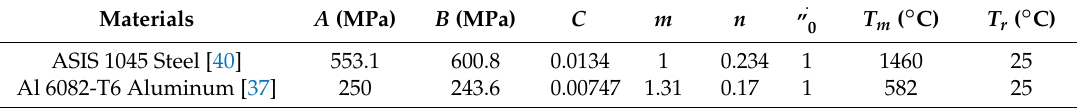
Table 1. Johnson–Cook (J–C) model constants obtained from split Hopkinson pressure bar (SHPB) tests.